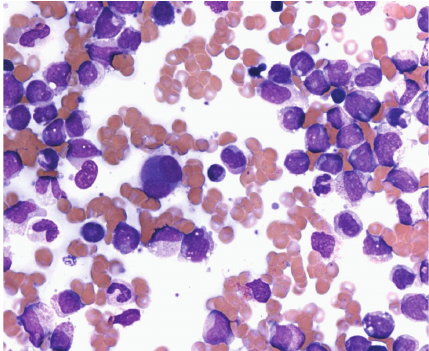
Figure 4: Bone marrow aspirate smear showing medium-to-large sized myeloblasts with moderate cytoplasm, round to lobulated or bean-shaped nuclei, and variably conspicuous nucleoli. (H&E. 400 ×